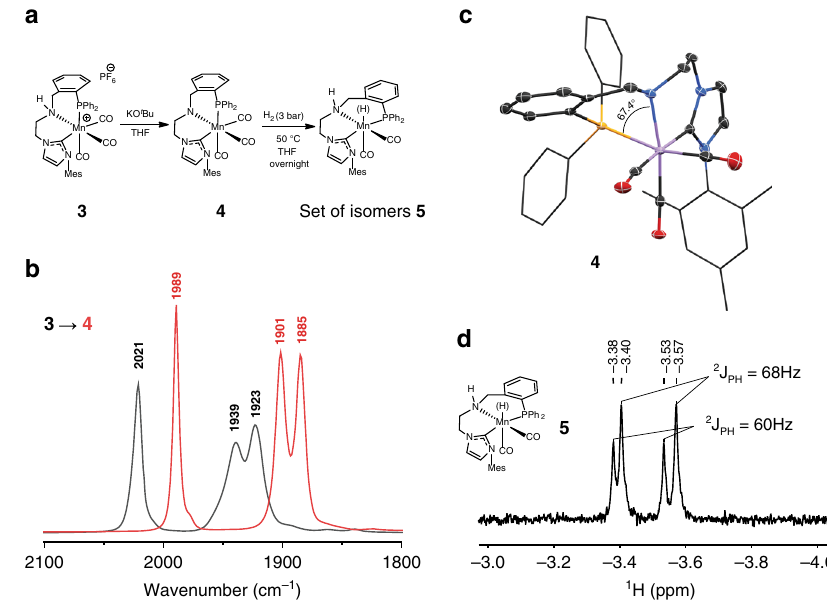
Fig. 3 Activation and reactivity of complex 3. a Generation of complex 5 upon reaction with H 2 (3 bar). b IR spectra of complex 3 (black) and in situ generated complex 4 (red) recorded in THF at 25 °C. c Molecular structure of complex 4 in the crystal with thermal ellipsoids drawn at 50% probability. d Hydride region of 1 H NMR (THF- d 8 ) spectra of in situ generated isomers of complex 5 (see Supplementary Fig. 19 for full spectra and analysis of isomers of 5 , conversion of 4 – 5 estimated at 24% by 1 H